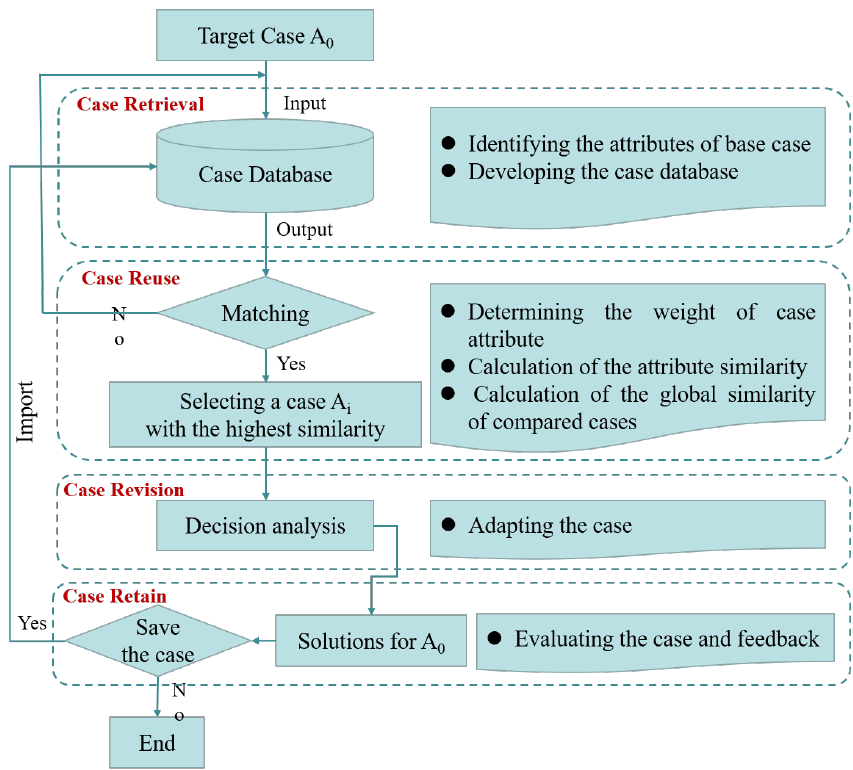
Figure 1. Logical framework and implementation step of the CBR model.